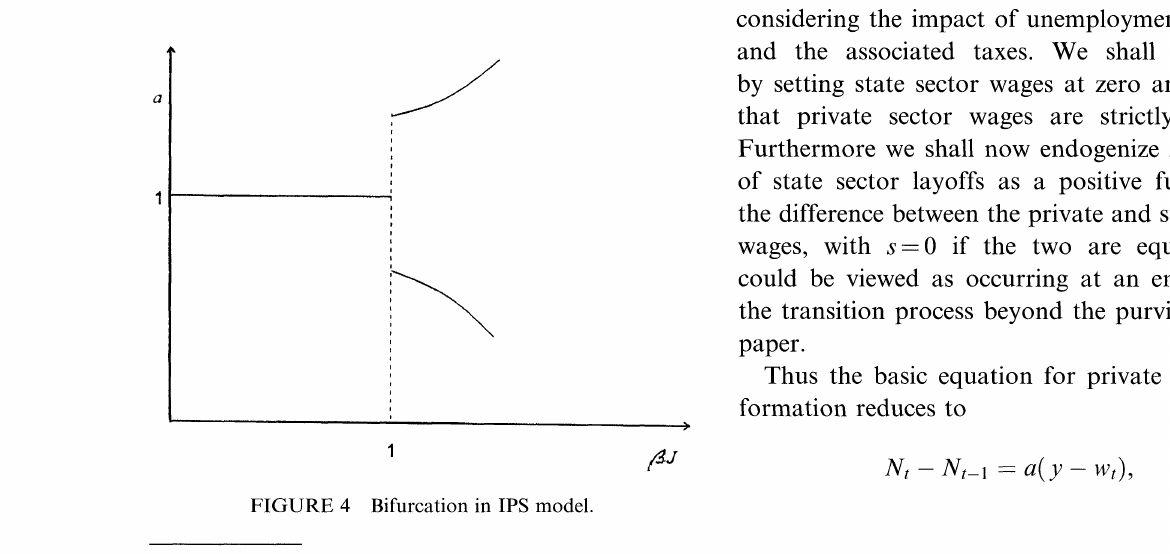
FIGURE 4 Bifurcation in IPS